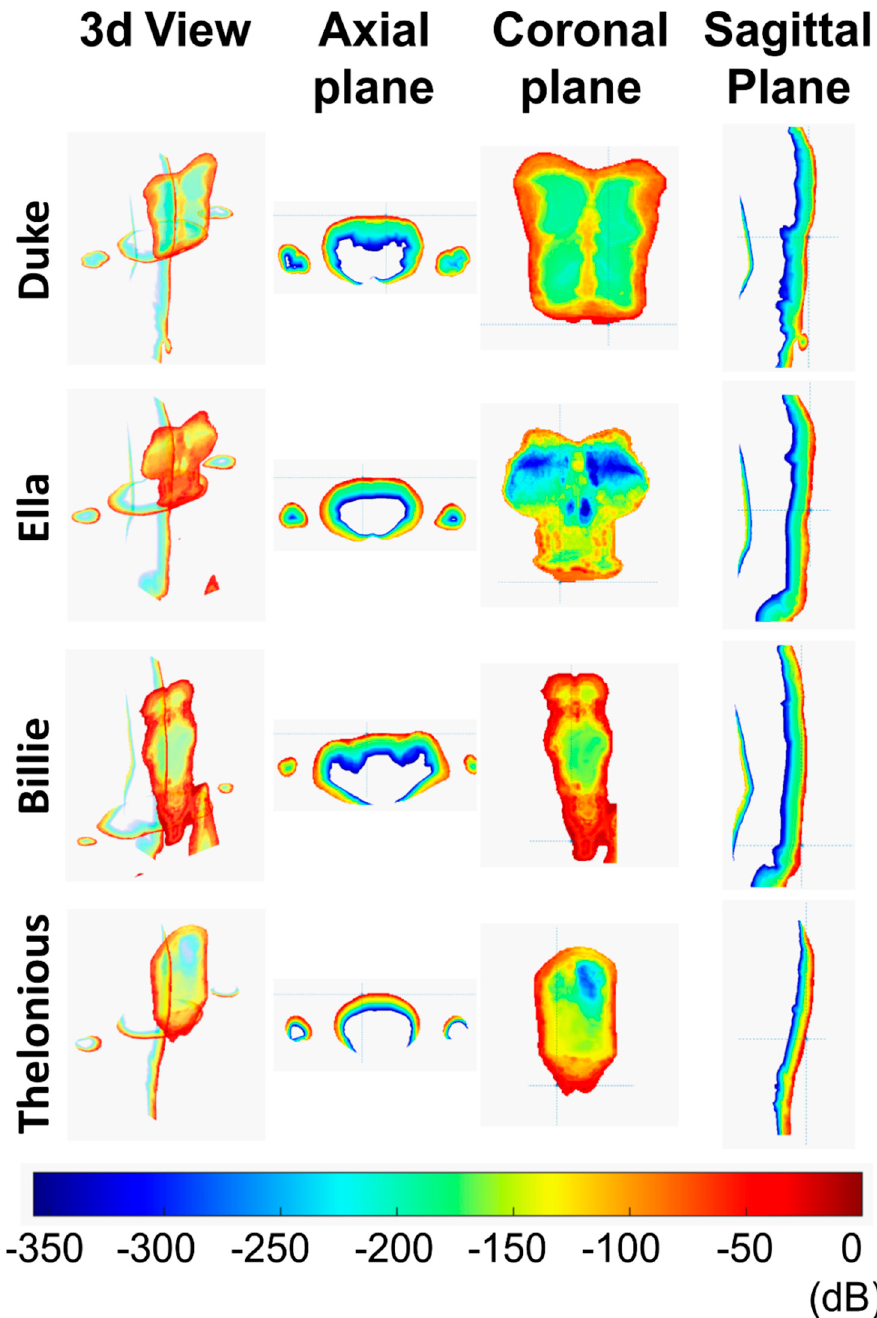
Figure 7. SAR distribution in the browsing scenario in three different planes: axial, coronal, and sagittal.